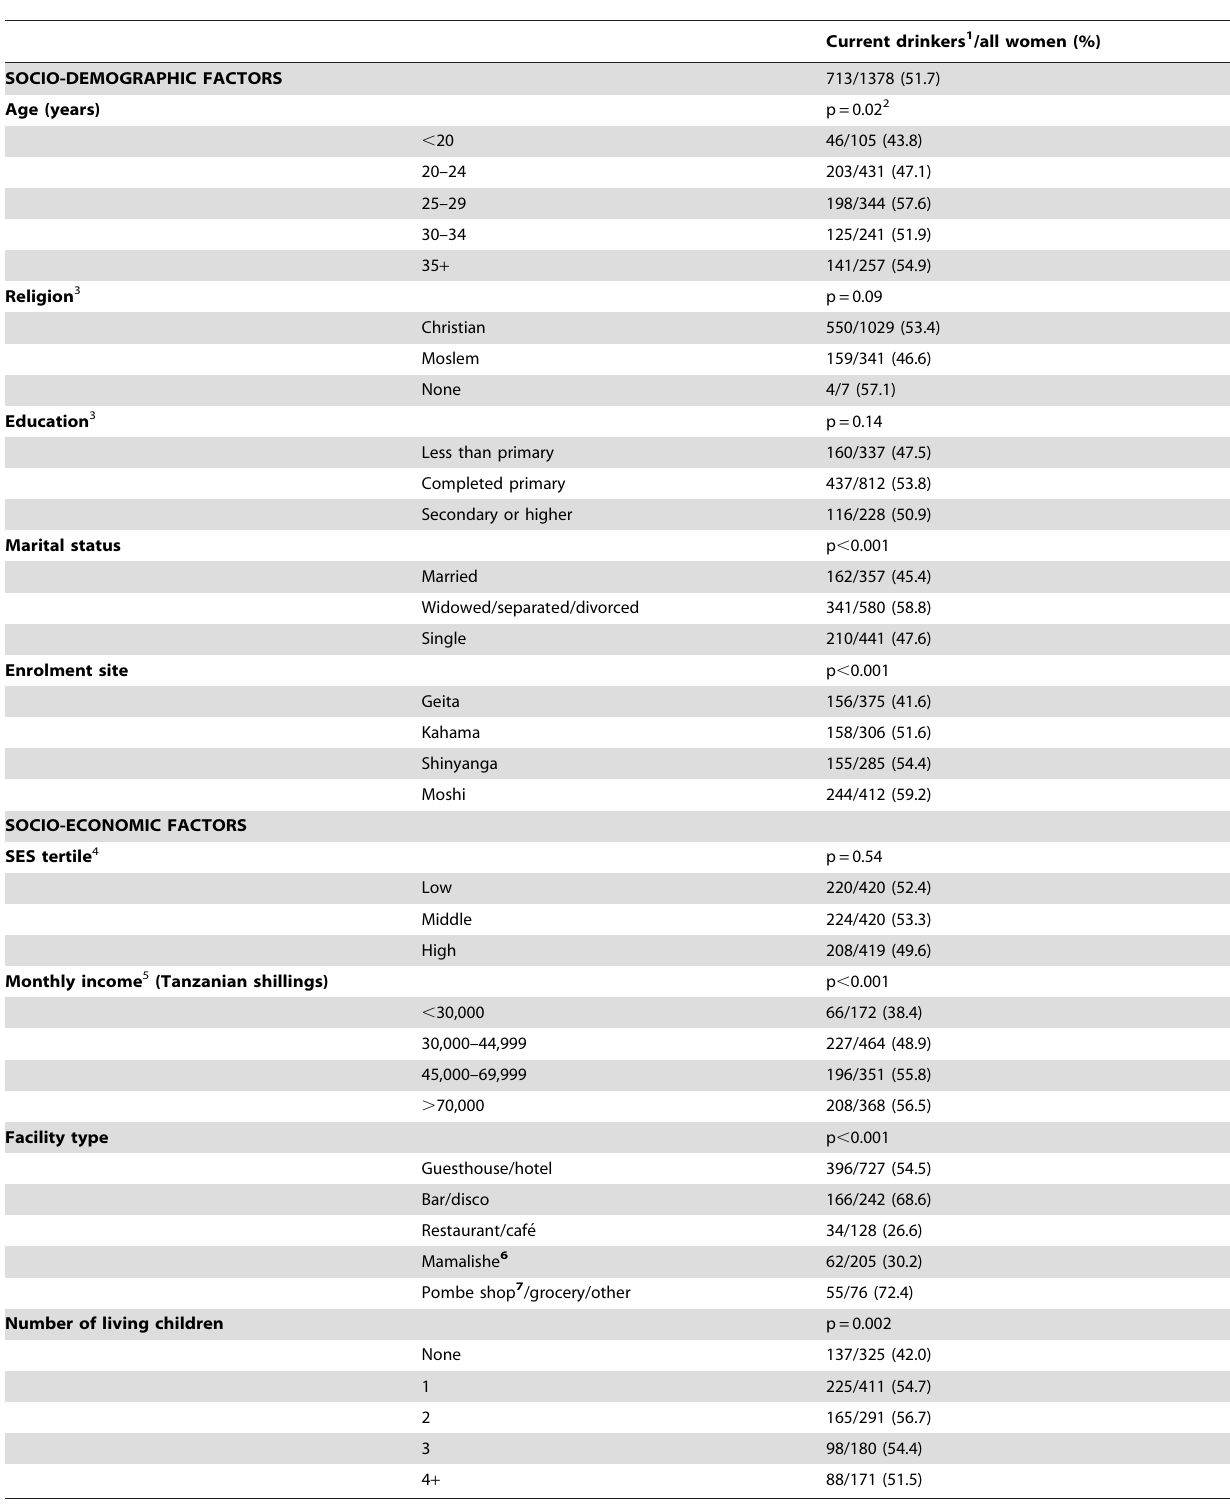
Table 2. Characteristics of women who reported drinking alcohol in the past 12 months among women working in food and recreational facilities in northern